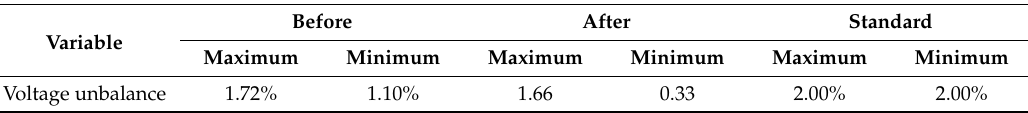
Table 3. Comparison of voltage unbalance.